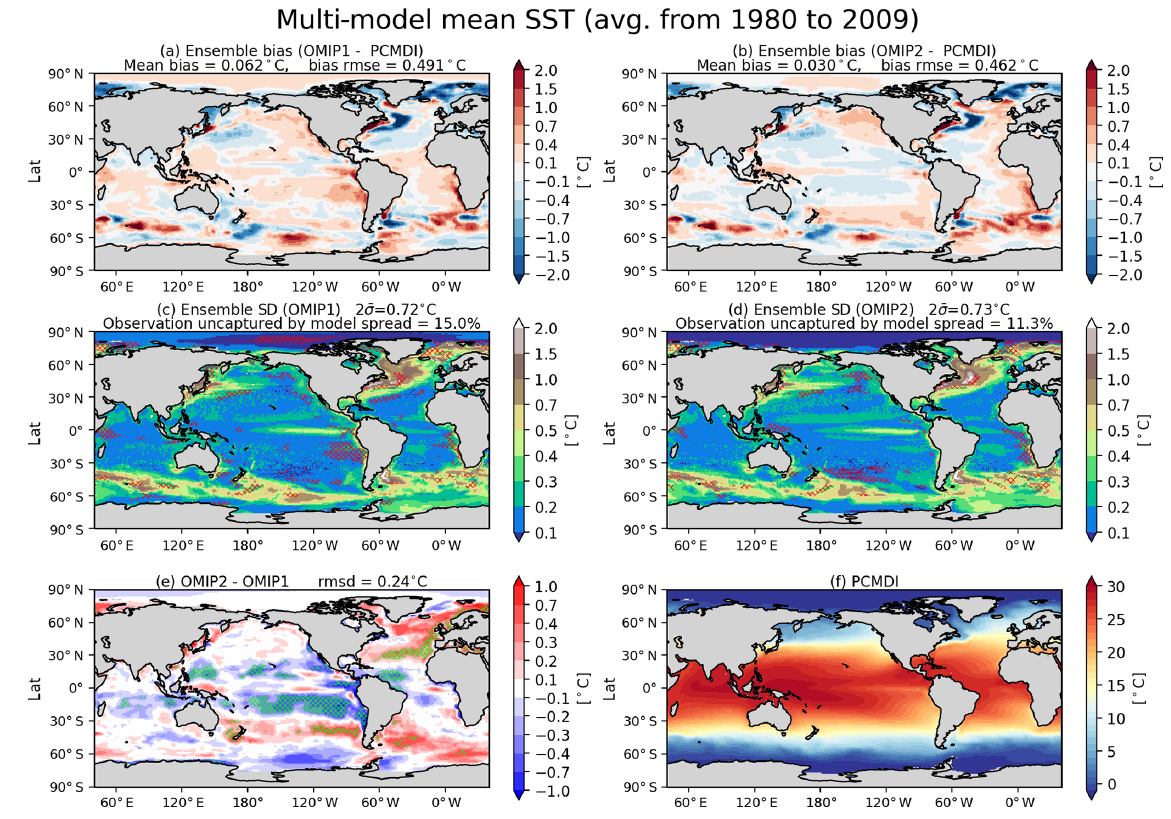
Figure 6. Evaluation of the simulated mean sea surface temperature (SST; units in ◦ C). Panels (a) and (b) show the bias of the multi-model mean, 30-year (1980–2009) mean SST relative to an observational estimate provided and updated by Program for Climate Model Diagnosis and Intercomparison (PCMDI) following a procedure described by Hurrell et al. (2008) (hereafter referred to as PCMDI-SST). (a) OMIP-1 and (b) OMIP-2, with global mean bias and global root mean square bias depicted at the top. The middle two panels show the standard deviation of the ensemble, with the regions where the observation is outside the 95% confidence range of the model spread ( ± 2 σ ) hatched with red. (c) OMIP-1 and (d) OMIP-2, with the global mean confidence range (twice the standard deviation) and the fraction of the region where observation is uncaptured by the model confidence range depicted at the top. (e) Difference between OMIP-1 and OMIP-2 (OMIP-2 minus OMIP-1), with the global root mean square difference depicted at the top. The regions where the difference is significant at 95% confidence level are hatched with green, with the uncertainty of multi-model mean difference computed based on the method proposed by Wakamatsu et al. (2017). (f) The 30-year (1980–2009) mean SST of PCMDI-SST. In the following figures, all models are used for multi-model mean. See Figs. S10–S12 for results of individual